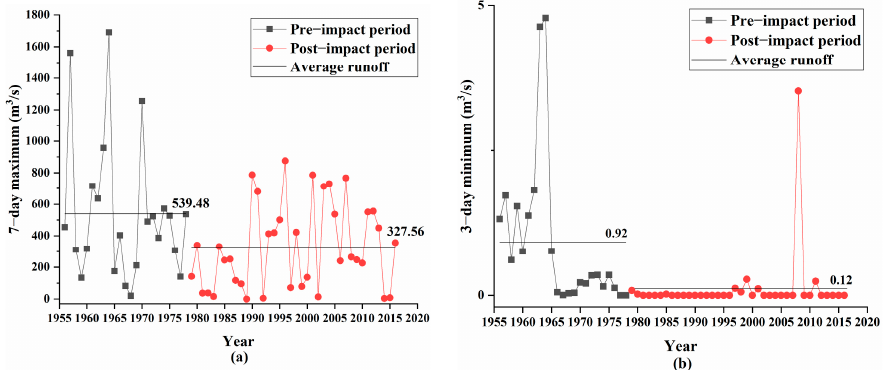
Figure 10. 7-day maximum ( a ) and 3-day minimum ( b ).